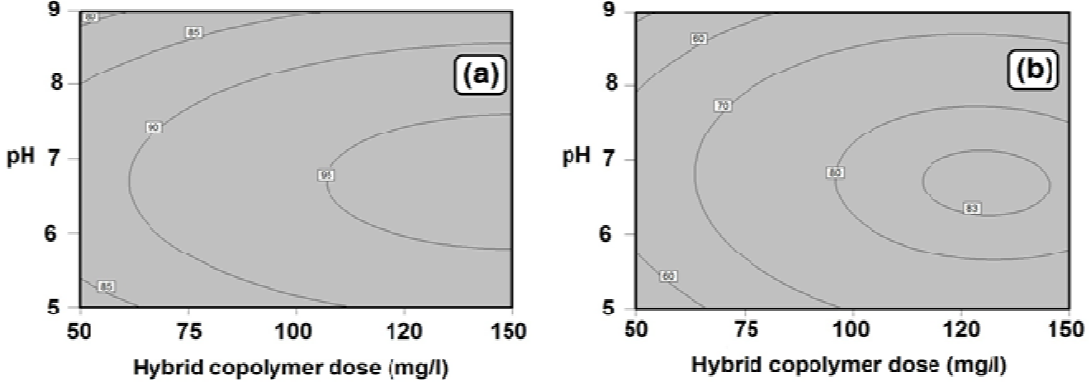
Figure 6. 2D contour plot for ( a ) turbidity removal; and ( b ) for COD